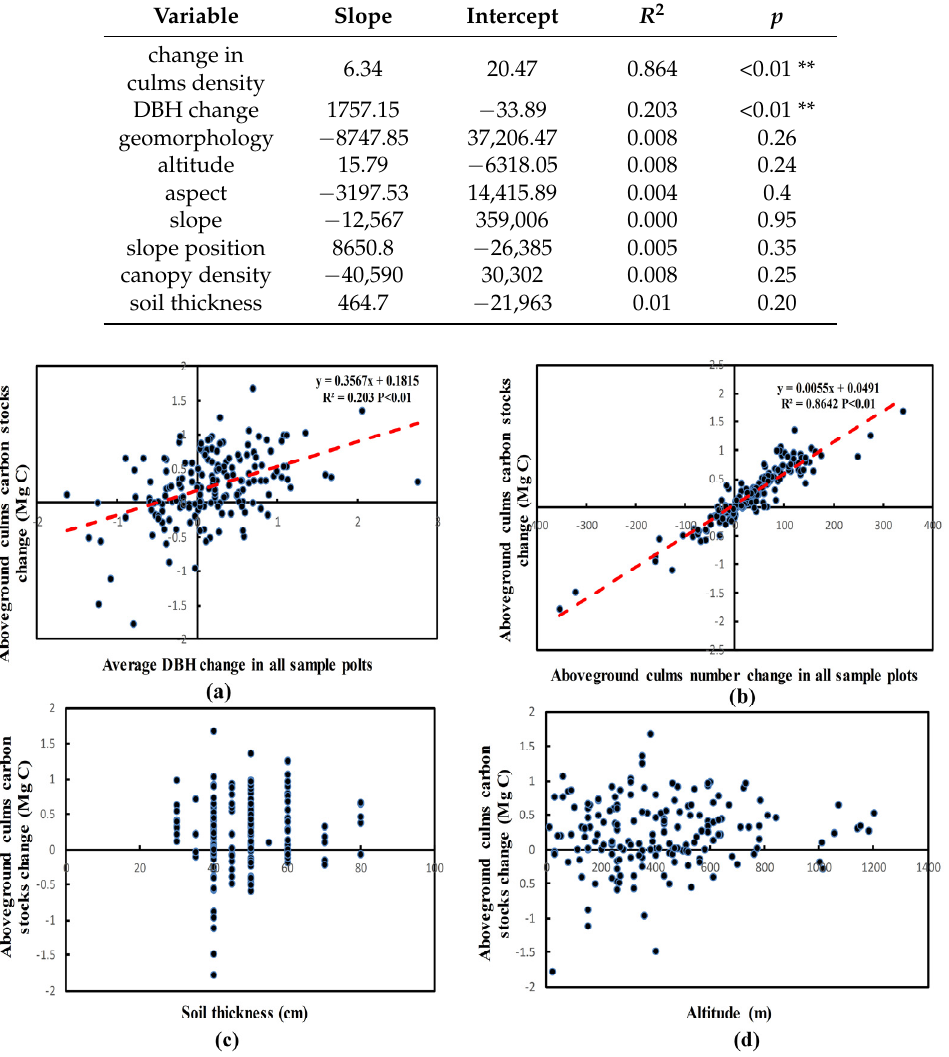
Figure 4. Relationship between culms carbon stocks and average DBH changes ( a ), culms number changes ( b ), soil thickness ( c ), and altitude ( d ) among sample plots.